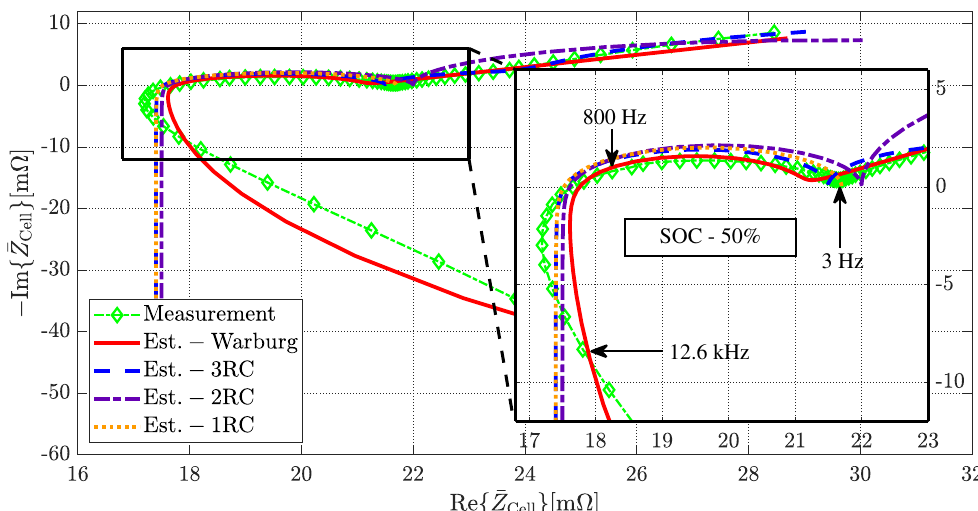
Figure 7. Obtained Nyquist plot from EIS measurements (green) in comparison to the parameterized Warburg impedance (red) and three- RC -pair (blue) model for a cylindrical 18650 battery cell from LG Chem of model type HG2 with a nominal capacity of